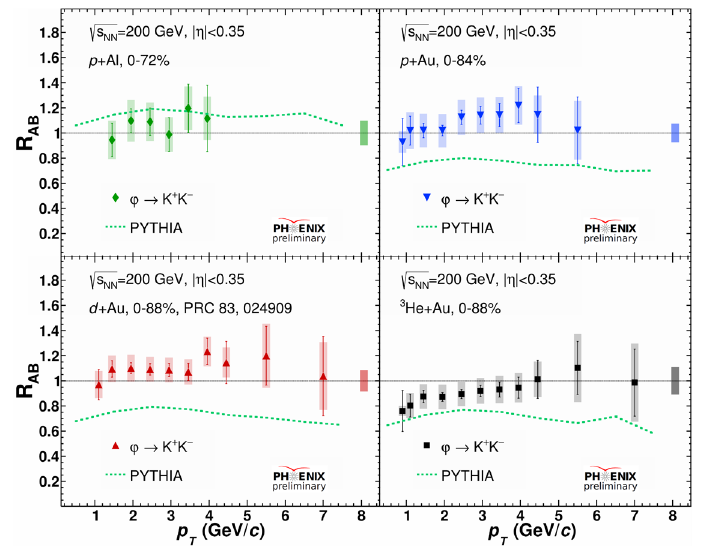
Figure 2: The comparison of φ meson R AB in p + Al, p + Au, d + Au, and 3 He + Au collisions at = 200 GeV at midrapidity ( p s NN predictions.